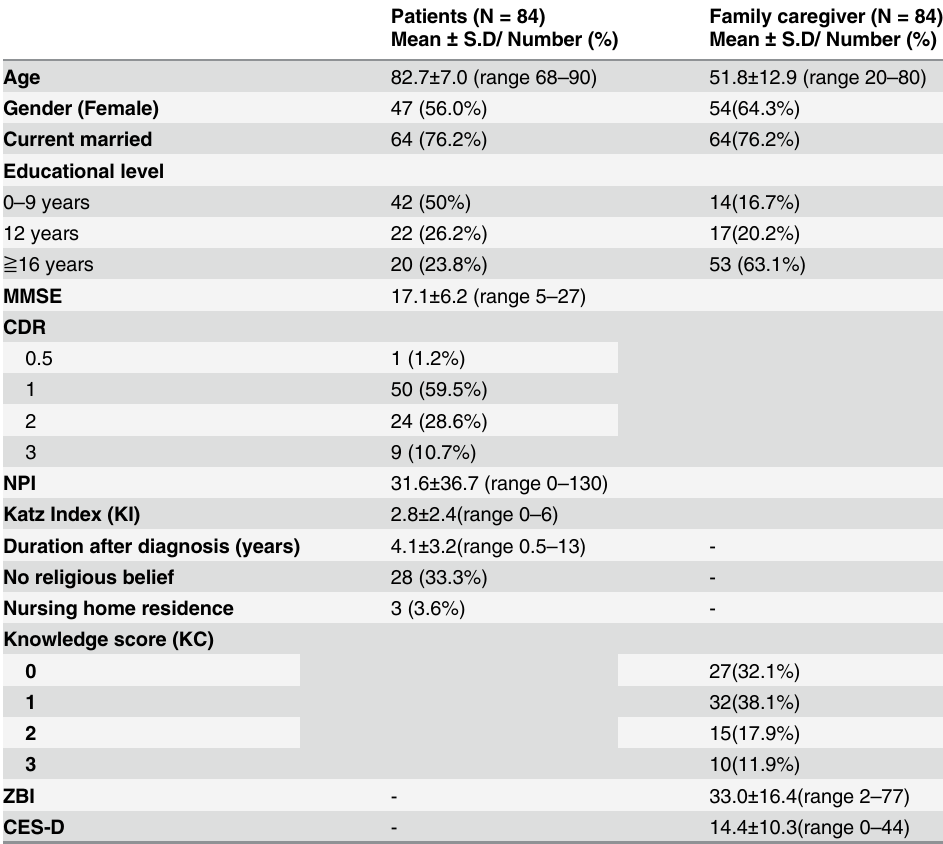
Table 1. Demographic and clinical characteristics of the patients and their